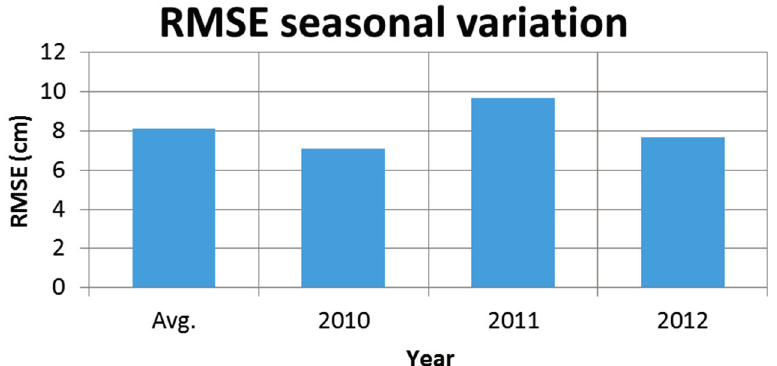
Figure 8. Seasonal variation of the RMSE for simulated snow depth. The first bar is the average RMSE for all simulated winter seasons. The other bars are the RMSE of each particular simulated winter season.